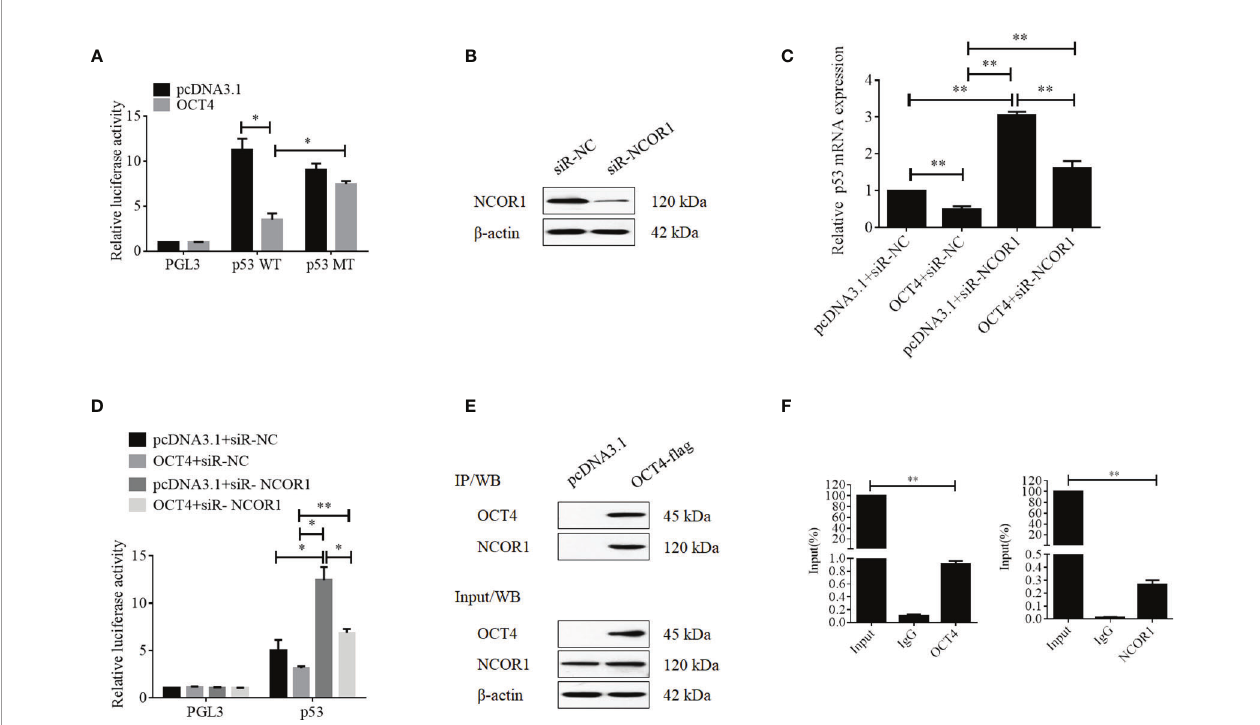
Figure 10 OCT4 suppressed p53 expression by binding to the promoter with co-repressor NCOR1. (A) Relative luciferase activity of SiHa cells transfected with the PGL3, p53-wild type, or p53-mutated constructions was measured under normal or overexpression of OCT4. (B) The SiHa cells were transfected with control-siRNA or NCOR1-siRNA for 24 h. Then, the NCOR1 protein levels were detected by Western blot. (C) The SiHa cells were co-transfected with pcDNA3.1-OCT4 and/or NCOR1-siRNA for 24 h. Then, p53 mRNA levels were determined by RT-qPCR. (D) Relative luciferase activity of PGL3-p53 promoter in SiHa cells transfected with OCT4 overexpression plasmid and/or NCOR1-siRNA for 24 h. (E) The interaction between OCT4 and NCOR1 was veri fi ed by co-IP and Western blotting assays. (F) The ChIP/qPCR assay was performed to analyze the binding potential of OCT4 and NCOR1 in the p53 promoter region. * p < 0.05, ** p < 0.01 vs.